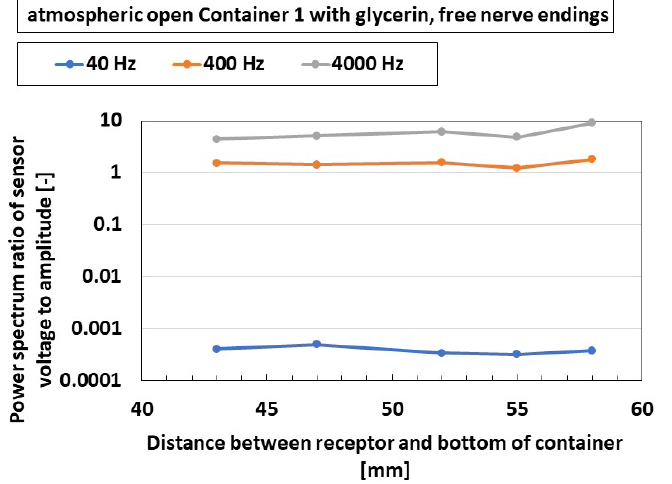
Figure 18. Experimental results of the vibrating auditory sensor with the vibration of a speaker when the frequencies are compared.